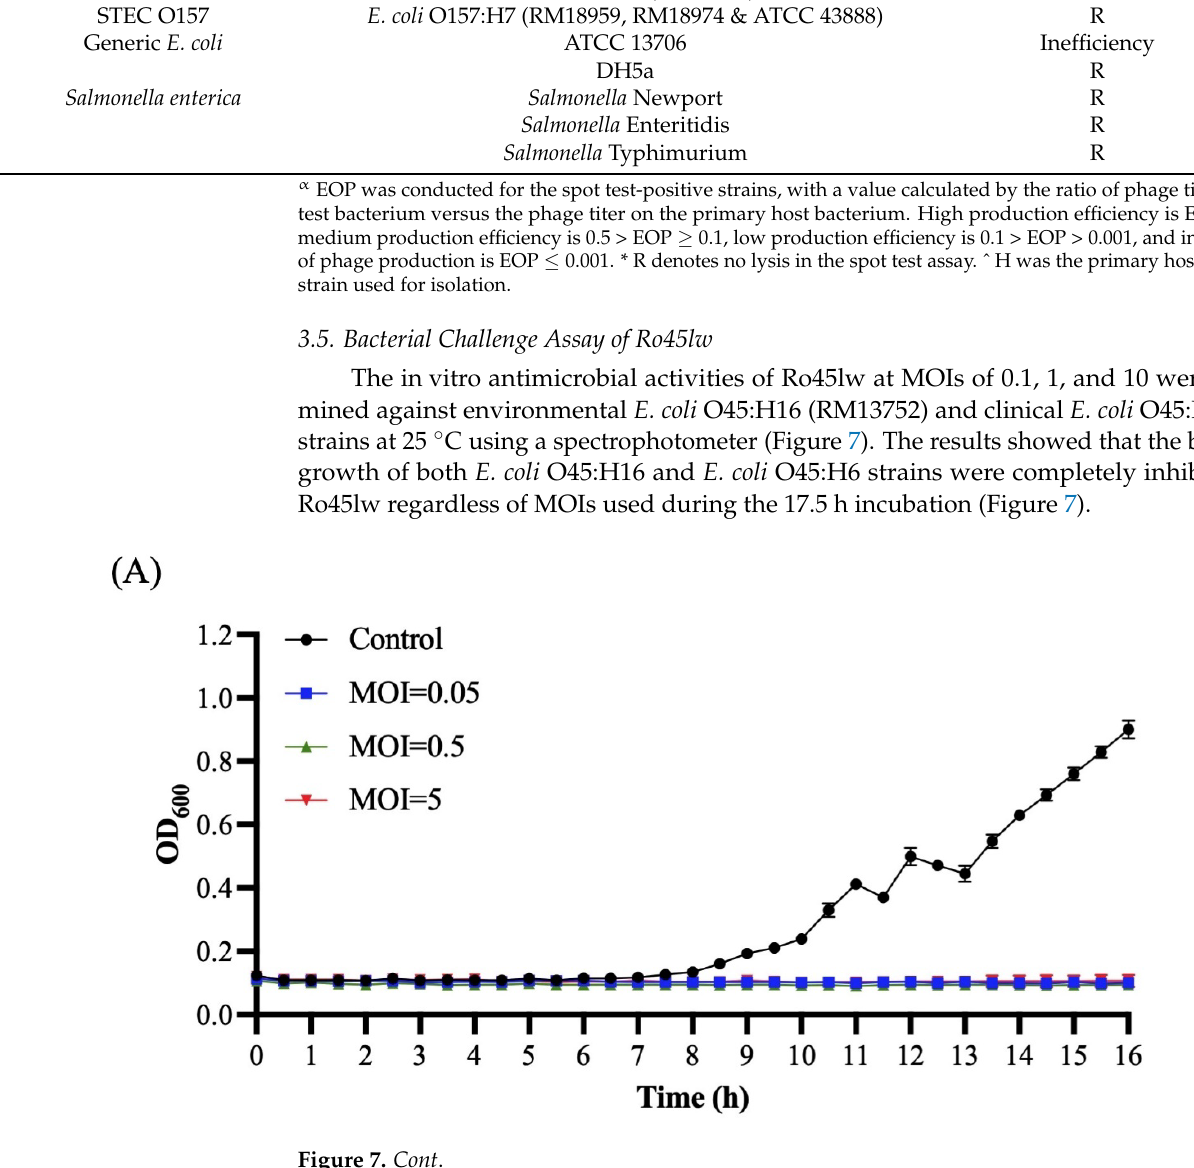
Figure 7. Bacterial challenge assay for E. coli O45:H16 ( A ) and E. coli O45:H2 ( B ) treated with phage Ro45lw at MOIs of 0.1, 1 and 10 at 25 °C for 17.5 h based on the bacterial optical density at wave- length 600 nm (OD 600 ). The Control group only contains bacterial culture. 4. Discussion Phage Ro45lw is a new member of podophages with a short tail, showing genomic classification in the genus of Kayfunavirus within the Autographiviridae family. Ro45lw does not share a close evolutionary relationship at the amino acid level with any of the 65 reference phages used in this study which also aligns with the VICTOR classification anal- ysis, showing no similarity to Ro45lw at the species level. The Ro45lw does not contain tRNA in the phage genome, which could be associated with a narrow host range of the phage [32]. This is related to high codon usage by the phages containing more tRNAs than those with few or none [32]. For podophages, T7-like phages in particular, the tail structure is composed of at least four proteins, including connector protein, tail tubular proteins, and fiber proteins [31]. Previous studies found that tail tubular protein A was associated with phage adherence